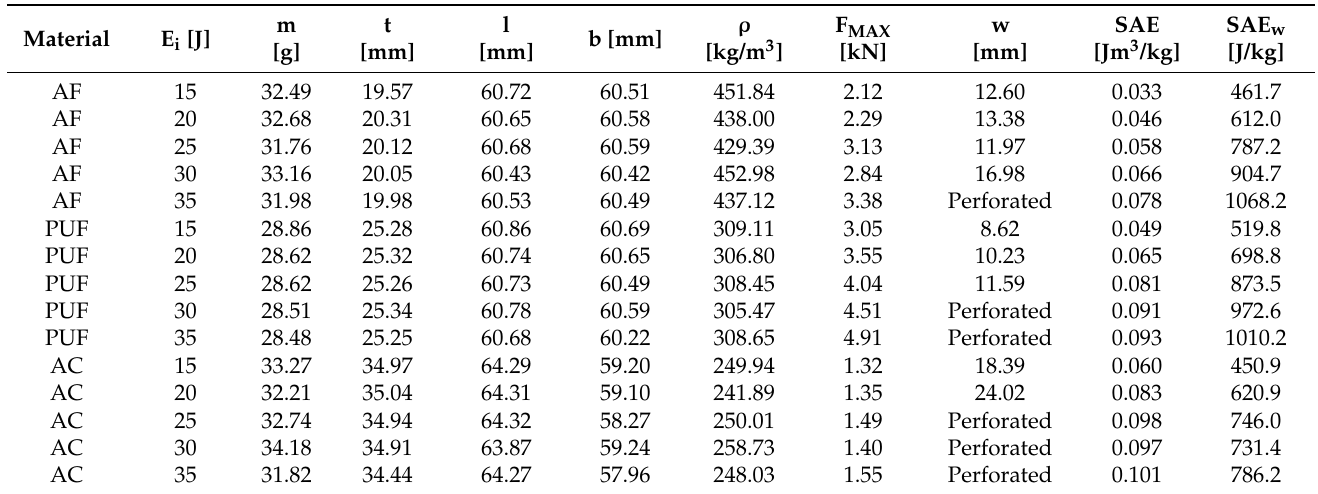
Table 2. Results of the impact